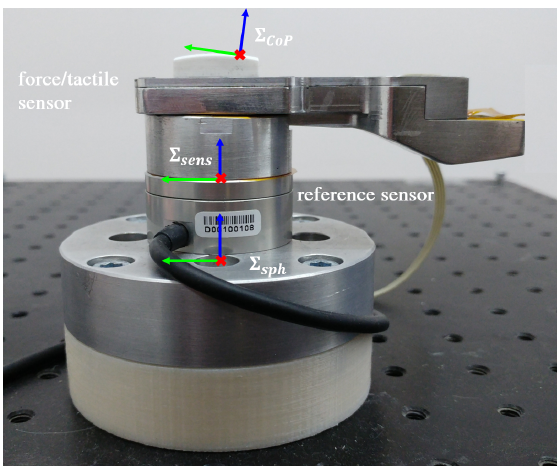
Figure 9. Testbench for sensor